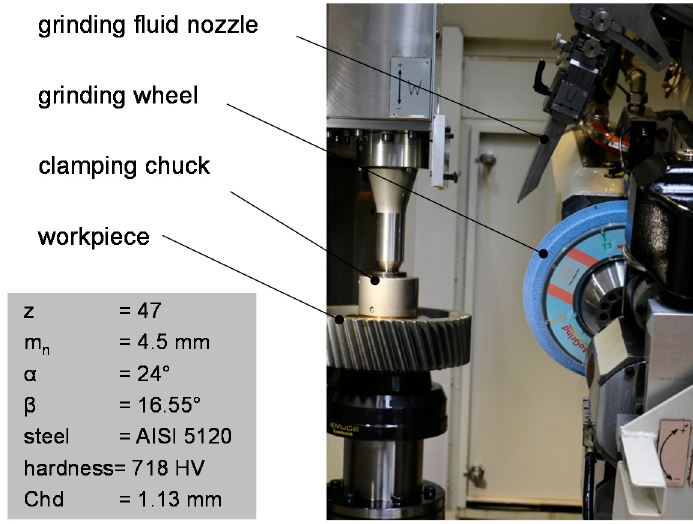
Figure 5. Experimental setup for grinding tests.